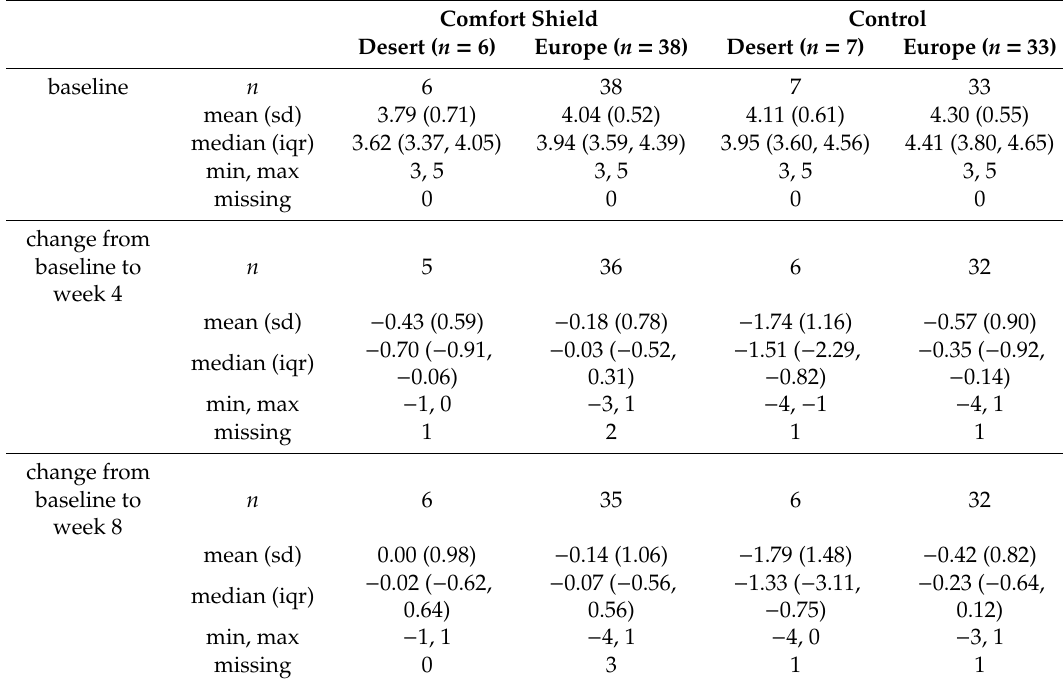
Table A6. CFS: value at baseline and change from baseline to each post-baseline visit—PPS ( n = 84)—descriptive analysis by subgroup.